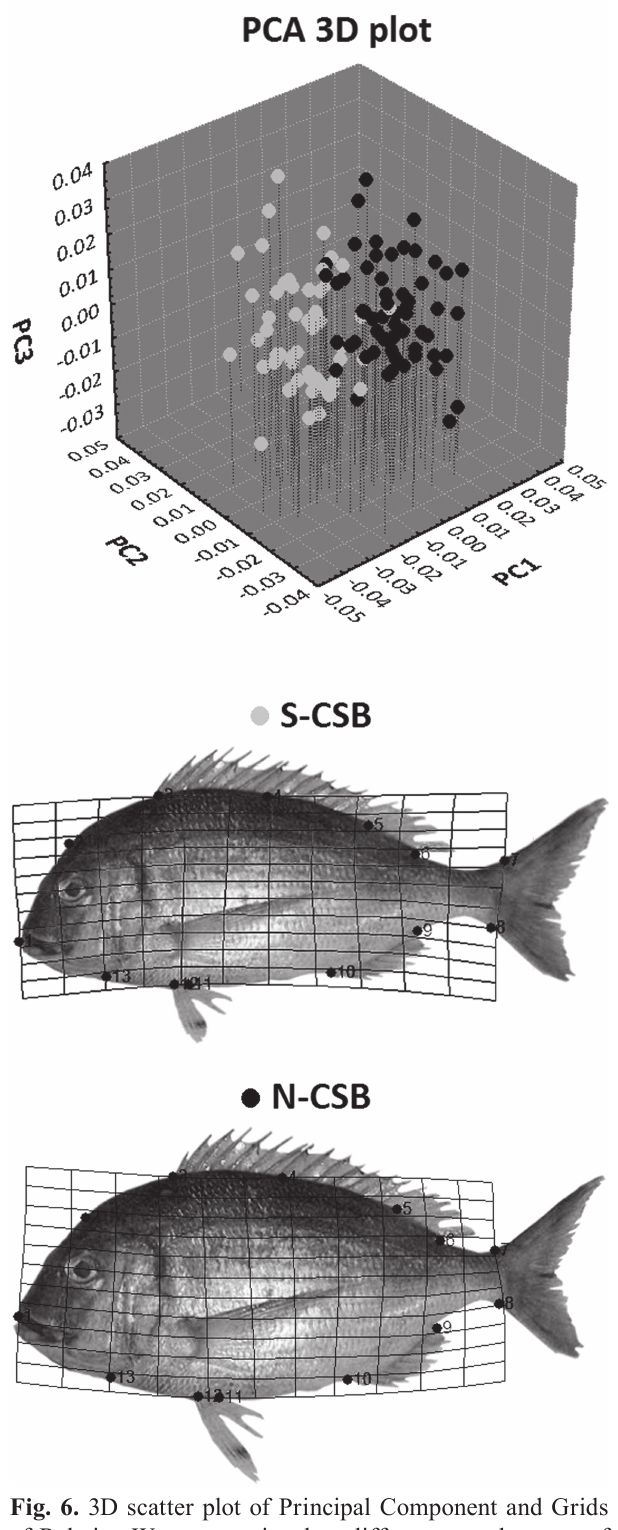
Fig. 6. 3D scatter plot of Principal Component and Grids of Relative Warps associated to different morphotypes of Pagrus pagrus . The S-CSB and N-CSB morphotypes are shown under the principal components graph (PC1, PC2 and PC3). S-CSB is represented with grey circles and N-CSB with black